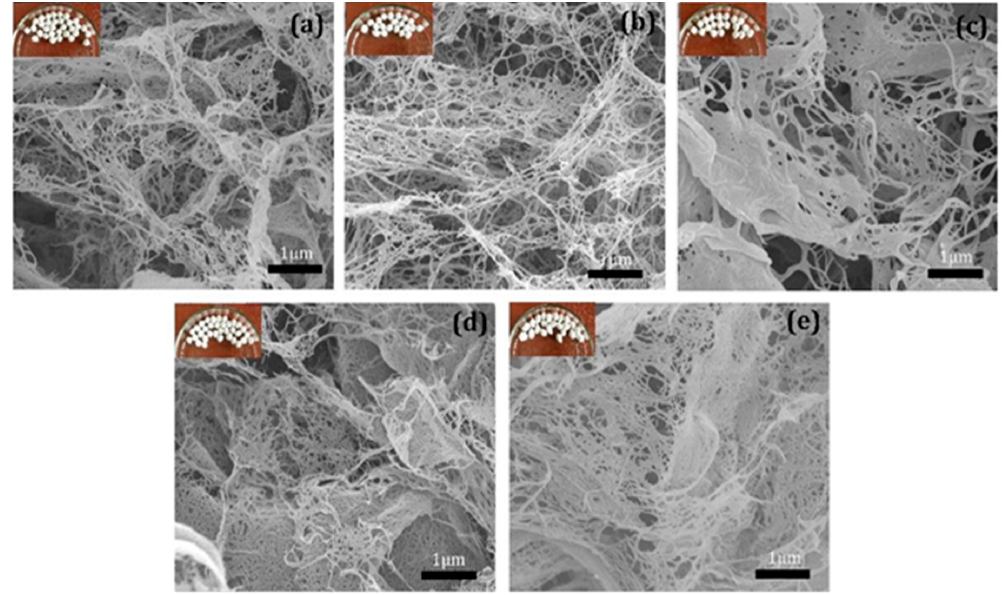
Figure 3. Scanning Electron Microscope images of ( a ) mix 1:3 (cellulose nanocrystal/cellulose nanofiber) aerogel, ( b ) mix 1:1 aerogel, ( c ) mix 3:1 aerogel, ( d ) cellulose nanocrystal aerogel, ( e ) cellulose